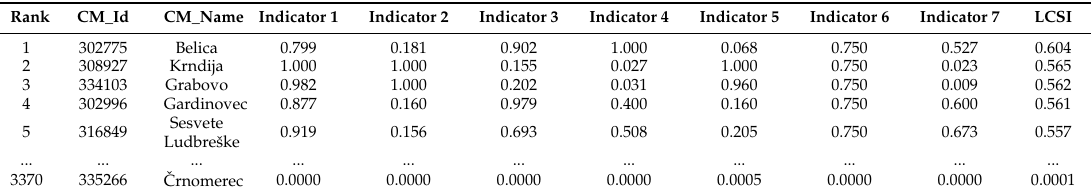
Table 4. WSM-EW CM